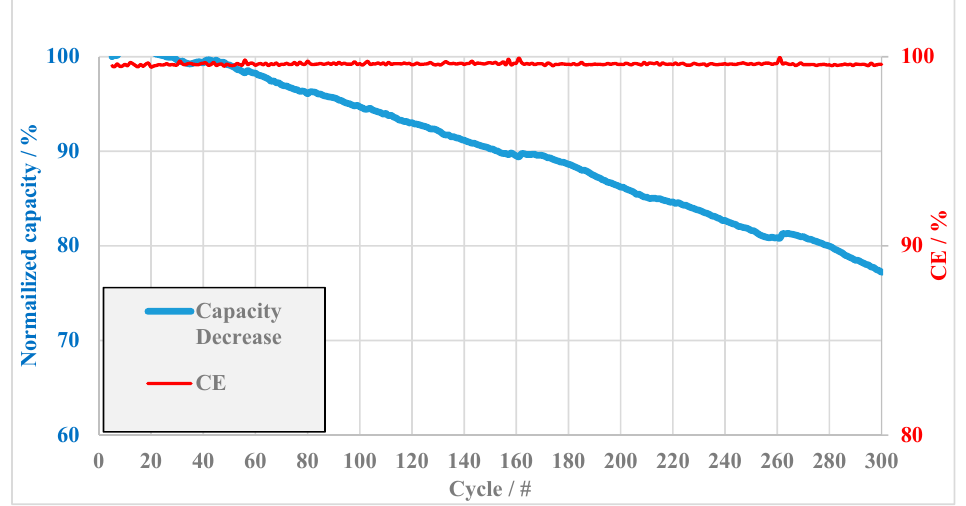
Figure 10. Long-term charging – discharging cycles test with BM-TMIm 4 membrane.